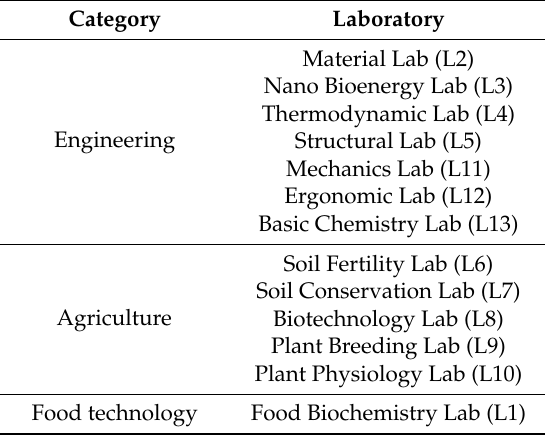
Table 3. Potential laboratories categories.